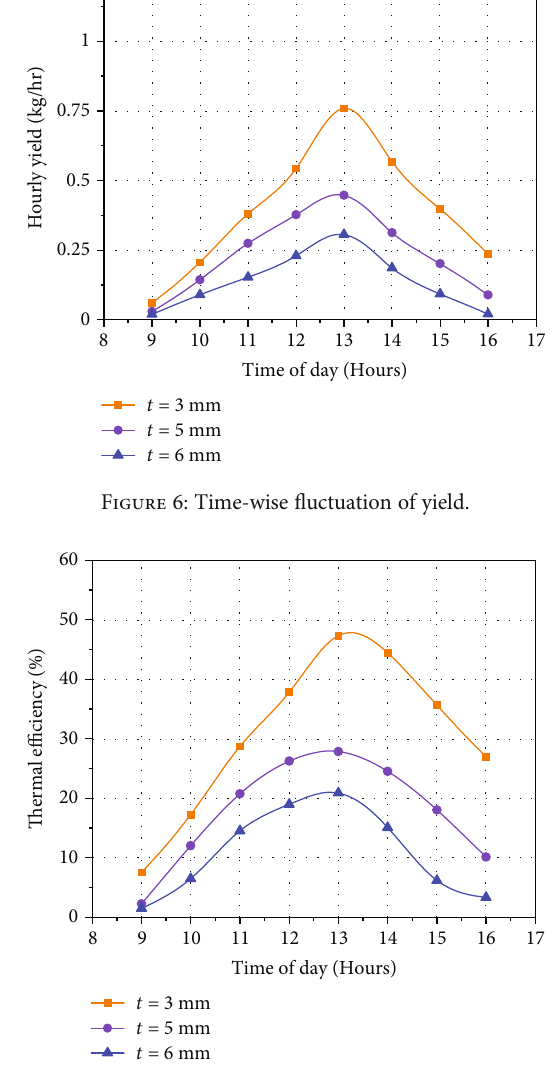
Figure 7: Time-wise fl uctuation of thermal e ffi ciency.